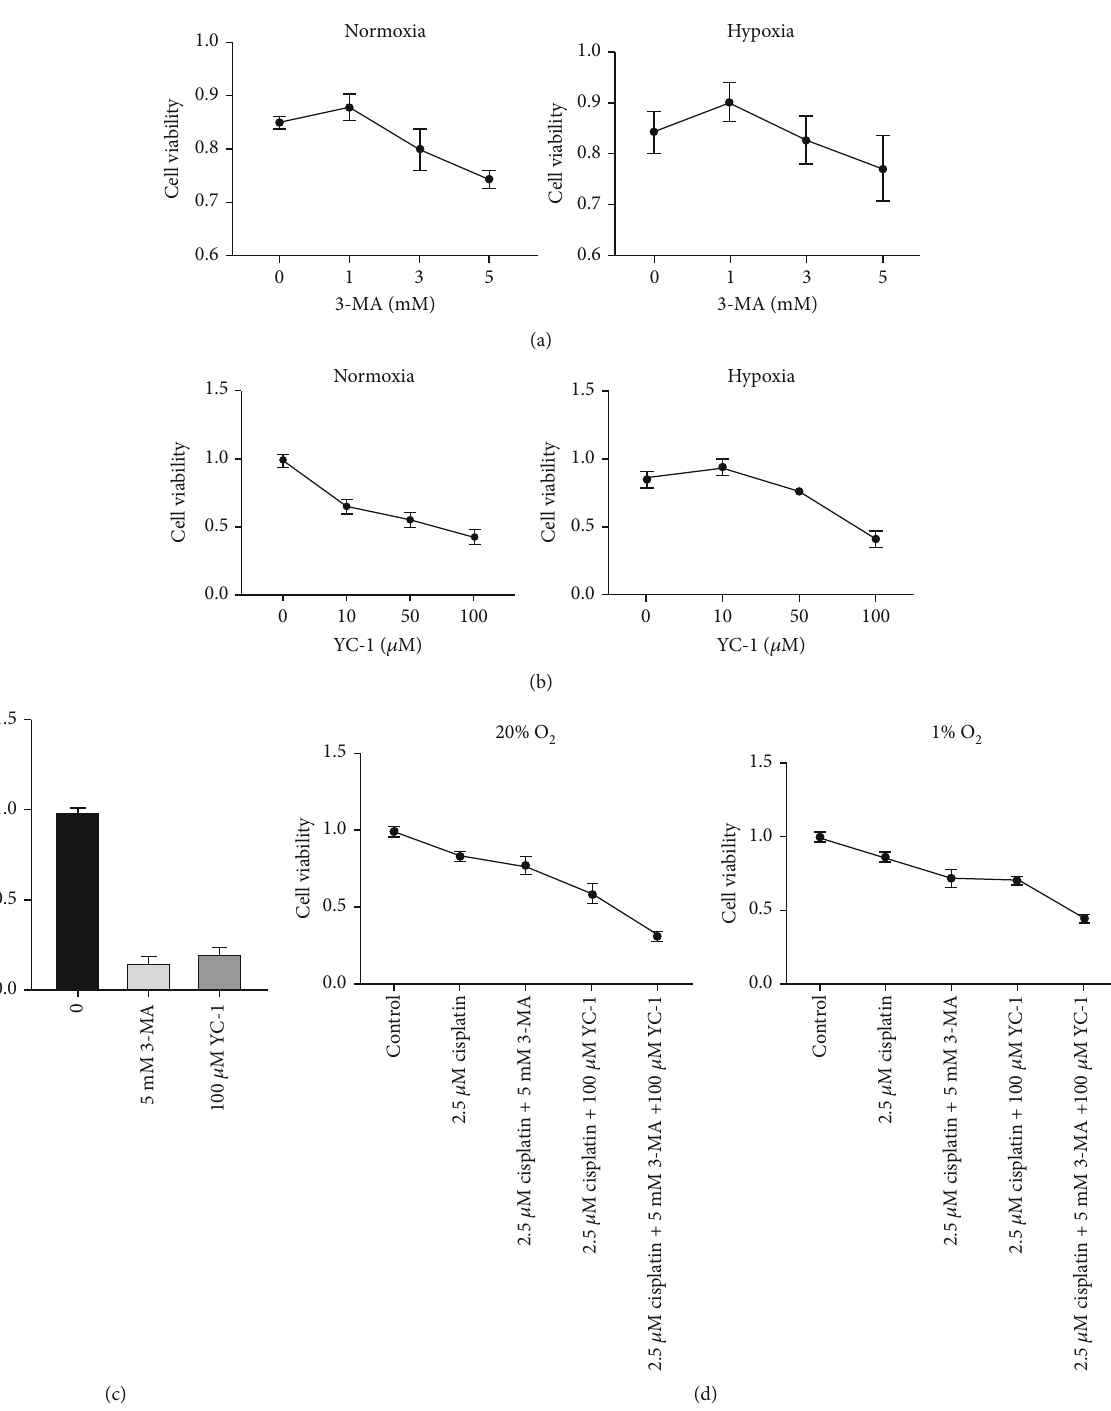
Figure 3: E ff ect of autophagy inhibitor and HIF-1 inhibitor on BIU-87 bladder cancer cell chemoresistance under hypoxia and normoxia. (a) Under normoxic and hypoxic, toxicity of cisplatin in BIU-87 cells was increased with the increased concentration of 3-MA. (b) Under normoxic and hypoxic, toxicity of cisplatin in BIU-87 cells was increased with increased concentration of YC-1. (c) The relative expression of HIF-1 in BIU-87 cells treated with 100 μ M YC-1. (d) Under normoxic and hypoxic conditions, viability of BIU-87 cells was observed in di ff erent